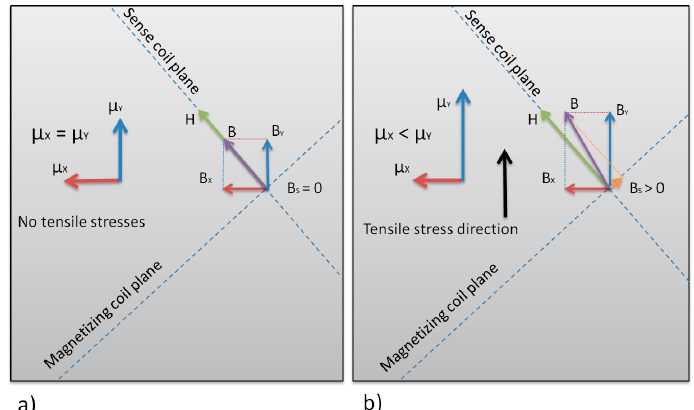
Figure 3. Mechanism of measurement voltage induced in the tensductor sensor. ( a ) No load, and ( b ) loaded.